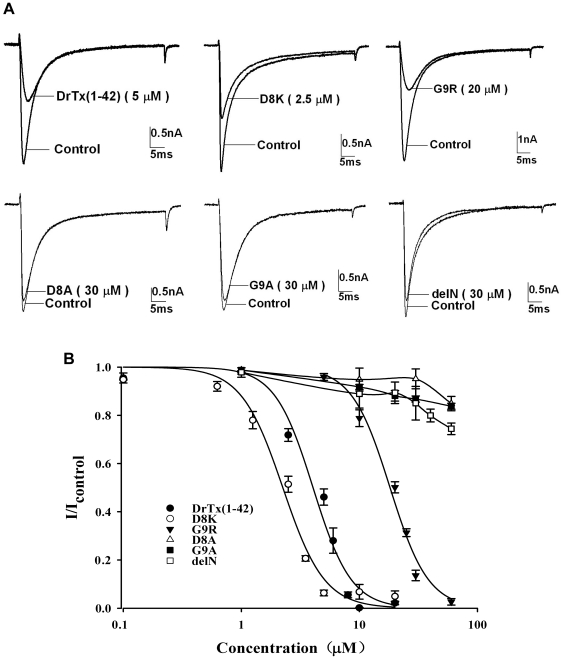
Effects of DrTx(1-42) and its mutants on TTX-R Na+ currents in rat DRG neurons (≤25 microm diameter).
A Representative current traces of TTX-R Na+ currents blocked by DrTx(1-42) and its mutants. TTX-R I
Na was evoked by 50 ms depolarization from a holding potential of −80 mV to −10 mV. B The concentration-dependent inhibition of TTX-R Na+ channels by DrTx(1-42) and its mutants. Each point is the mean ± SEM for n = 5–8. These data points (DrTx(1-42), D8K and G9R) were fitted according to the Hill equation, the yielded IC50 values as follows: DrTx(1-42): 4.05±0.35 µM; D8K: 2.25±0.15 µM; G9R: 18.19±1.02 µM. NOTE-Recombinant DrTx(1-42) prepared in this study possesses comparable potency on TTX-R I
Na with that previously reported (Zhu et al., 2011).